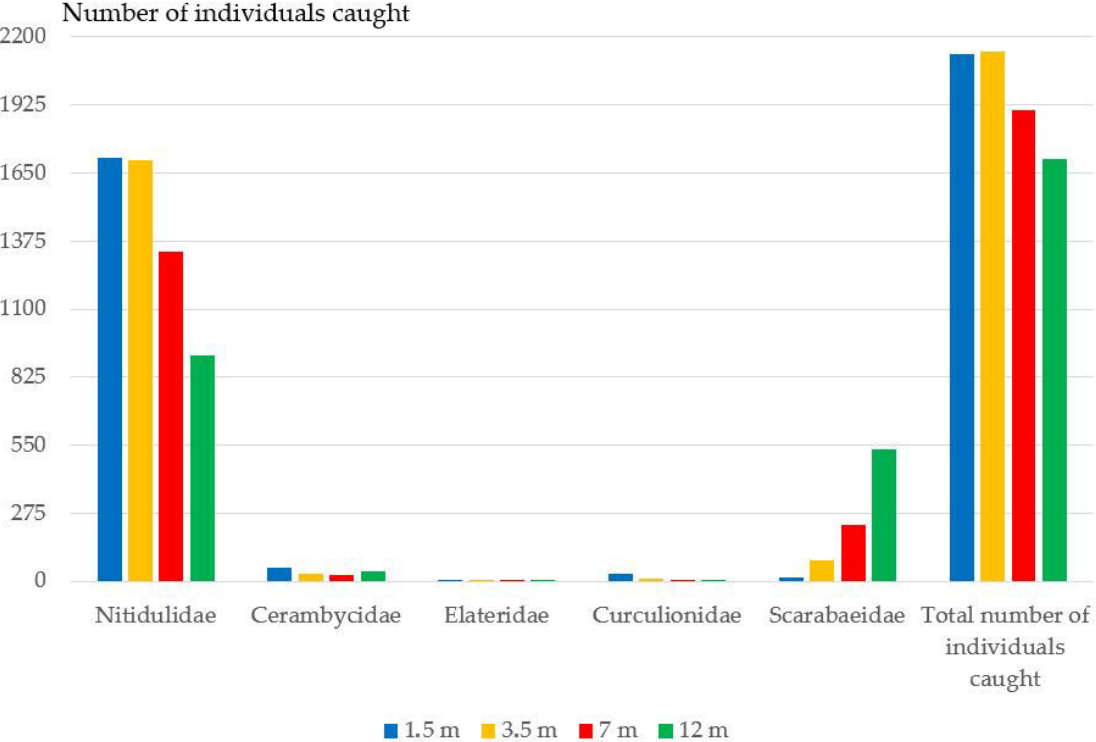
Figure 4. The number of individuals caught from five families collected using the bait traps at various height levels. Cryptarcha strigata (Fabricius, 1787) (a total of 3315 individuals), Glischrochilus hortensis (Geoffroy, 1785) (891 individuals), Protaetia marmorata (Fabricus, 1792) (821 individuals), Quedius dilatatus (Fabricius, 1787) (643 individuals), Cychramus luteus (Fabricius, 1787) (452 individuals), Soronia grisea (Linnaeus, 1758) (361 individuals), and Glischrochilus grandis (Tournier, 1872) (194 individuals) had the greatest numbers in beer traps. The following 15 species were found at all studied heights ( Dendroxena quadrimaculata (Scopoli, 1771), Quedius dilatatus , Protaetia marmorata , Cantharis nigricans O.F. Müller, 1776, Cryptarcha strigata , Cryptarcha undata (G.-A. Olivier, 1790), Cychramus luteus , Glischrochilus grandis , Glischrochilus hortensis , Glischrochilus quadripunctatus (Linnaeus, 1758), Soronia grisea , Dinoptera collaris (Linnaeus, 1758), Leptura quadrifasciata Linnaeus, 1758, Leptura thoracica (Creutzer, 1799), Rhagium mordax (De Geer, 1775), Anisandrus dispar (Fabricius, 1792)). The greatest species diversity (58 species) was recorded at a height of 1.5 m, the smallest one (40 species)—at of 7.5 m (Table A1). According to the average number of specimens, the highest numbers were obtained at heights of 1.5 and 3.5 m (on average of sampling point, 427 and 428 specimens, respectively). The minimum number of specimens was caught at a height of 12 m. The relative number of saproxylic beetle species was lower at low altitude, whereas at other altitudes it increased slightly. At heights of 3.5–12 m, the number of saproxylic species was almost the same (Table A1). The relative number of anthophilic species was also lower at low altitude. However, at other heights it sharply increased (Table A1). The calculated Shannon’s and Simpson’s diversity indices showed the following results. The maximum values of the Shannon’s diversity index and the minimum values of the Simpson’s diversity index are typical for a height of 1.5 m. Conversely, the minimum values of the Shannon’s diversity index and the maximum values of the